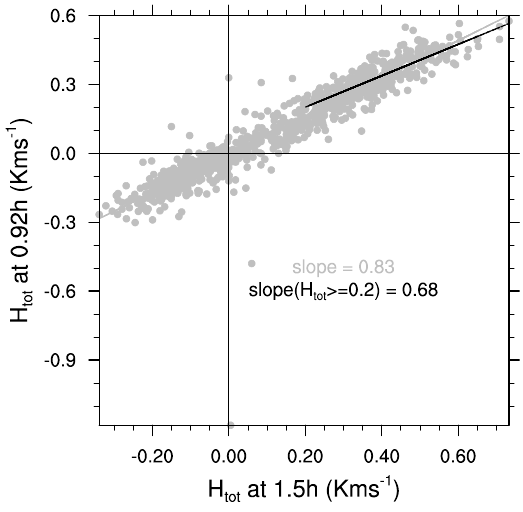
Figure 8. Scatter plot of the coherent structure contribution to kinematic heat flux ( H tot ) 839 Fig. 8. Scatter plot of the coherent structure contribution to kine- between the two heights (top; 1.5 h and mid; 0.92 h ). The black line represents the slope of 840 matic heat flux ( H tot ) between the two heights (top; 1.5h and mid; total heat flux greater than 0.2 K m s -­‐1 . 841 0.92h). The black line represents the slope of total heat flux greater than 0.2 Kms − 1 . 842